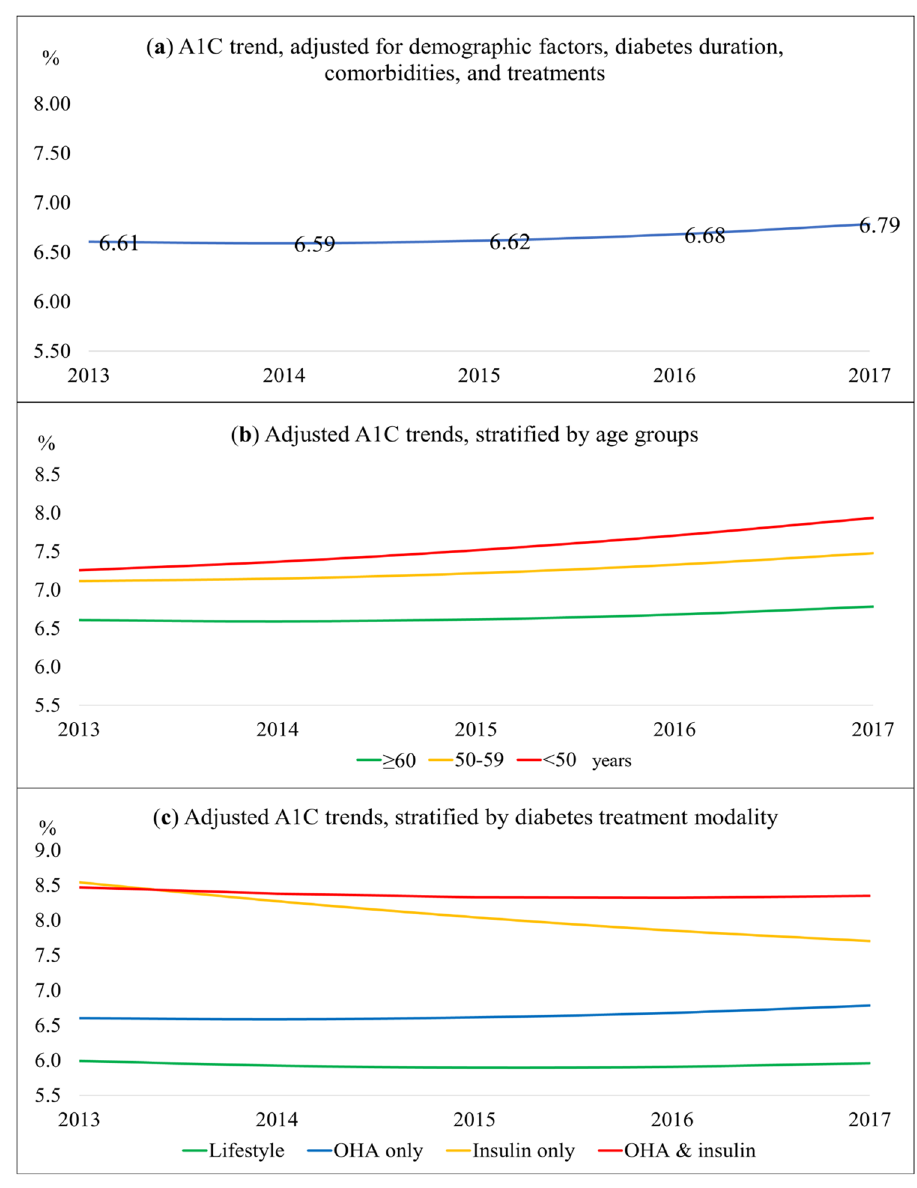
Figure 2. Multivariate linear mixed-effects model for A1C trends. ( a ) The adjusted baseline model was for Chinese ethnicity, aged ≥ 60, diabetes duration for < 5 years, normal BMI category, without hypertension, treated with OHA alone, not on antihypertensive agents, and no polypharmacy. ( b ) Adjusted A1C trends, stratified by age groups. ( c ) Adjusted A1C trends, stratified by diabetes treatment